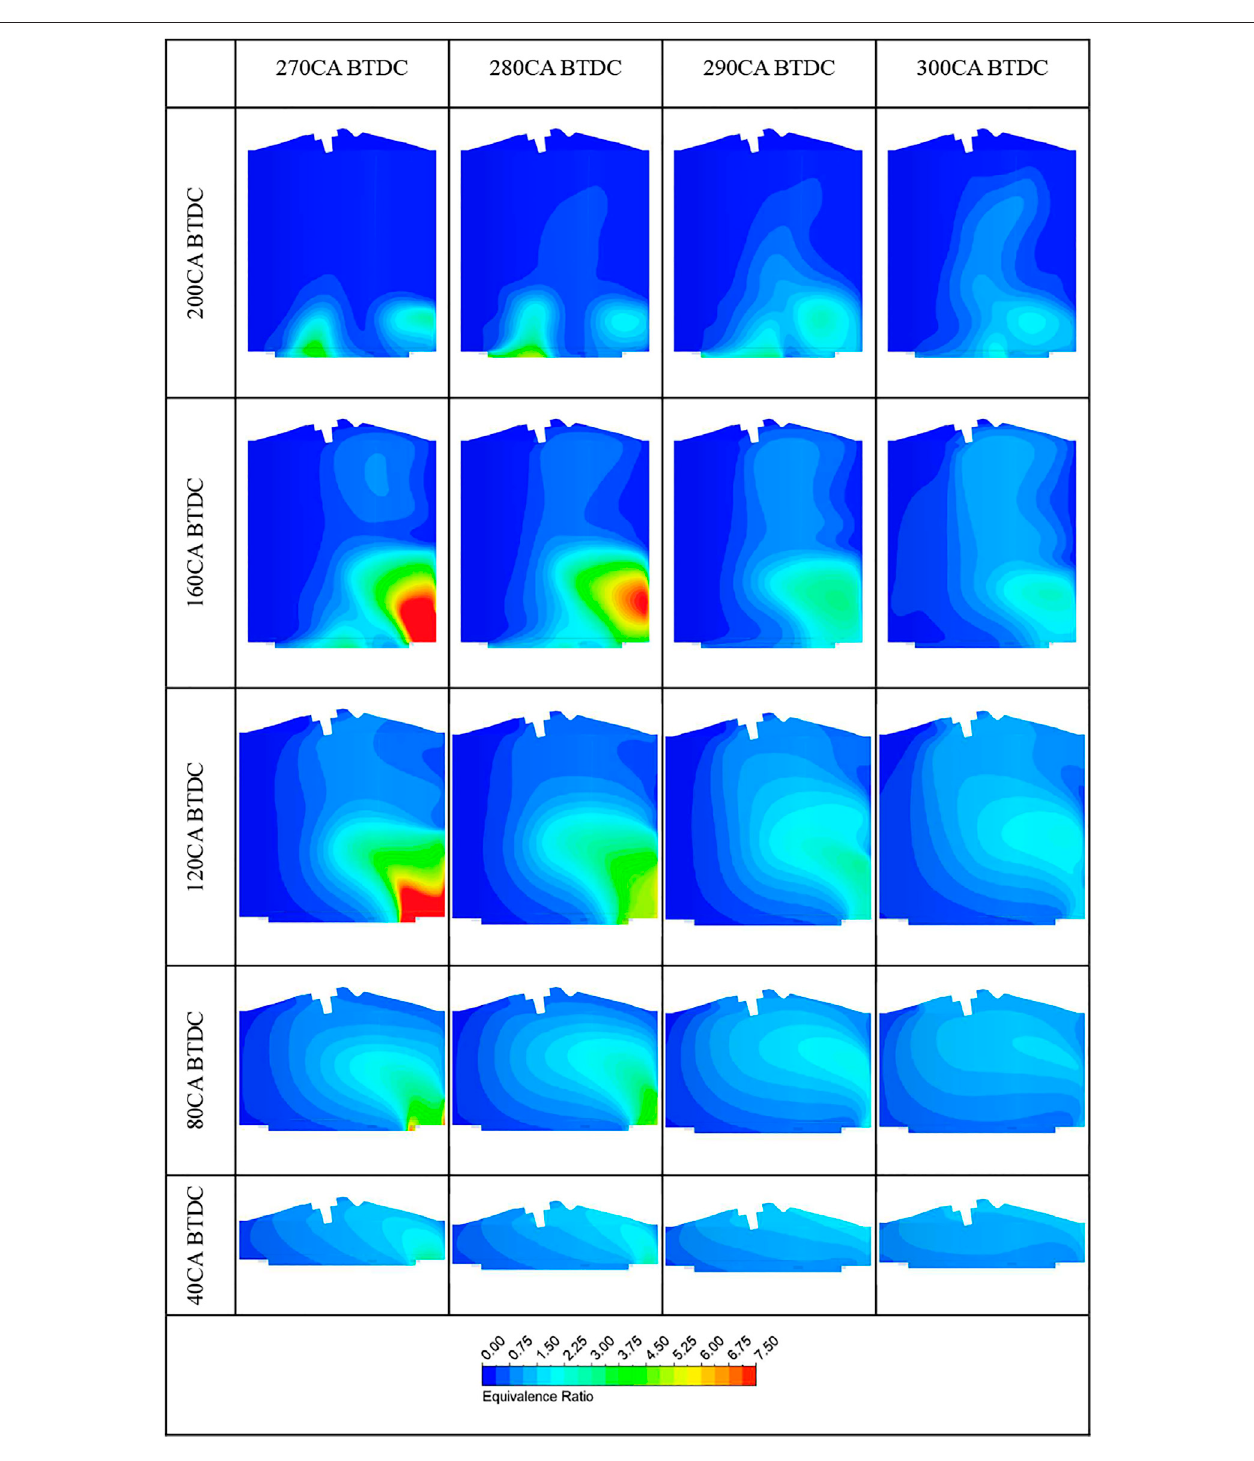
FIGURE 6 | Effect of injection timing on mixture formation at cylinder symmetry at several CAD before spark timing.